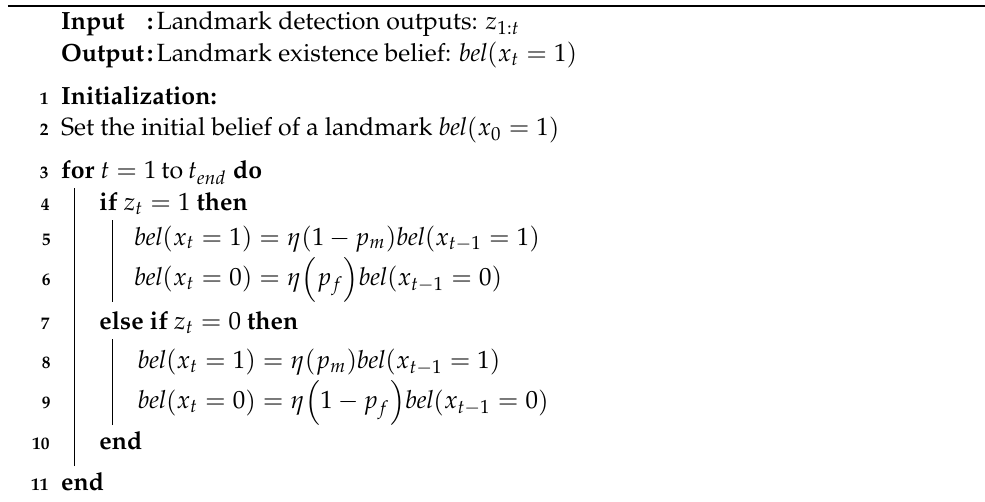
Algorithm 2: State estimation procedure for an existent landmark on the HD